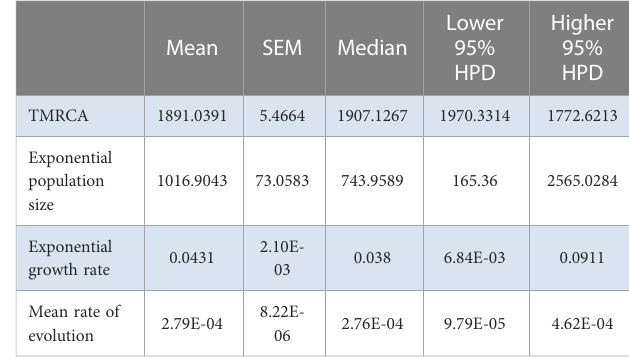
TABLE 7 Relevant estimates from the Bayesian analysis for the Iranian AMV population.